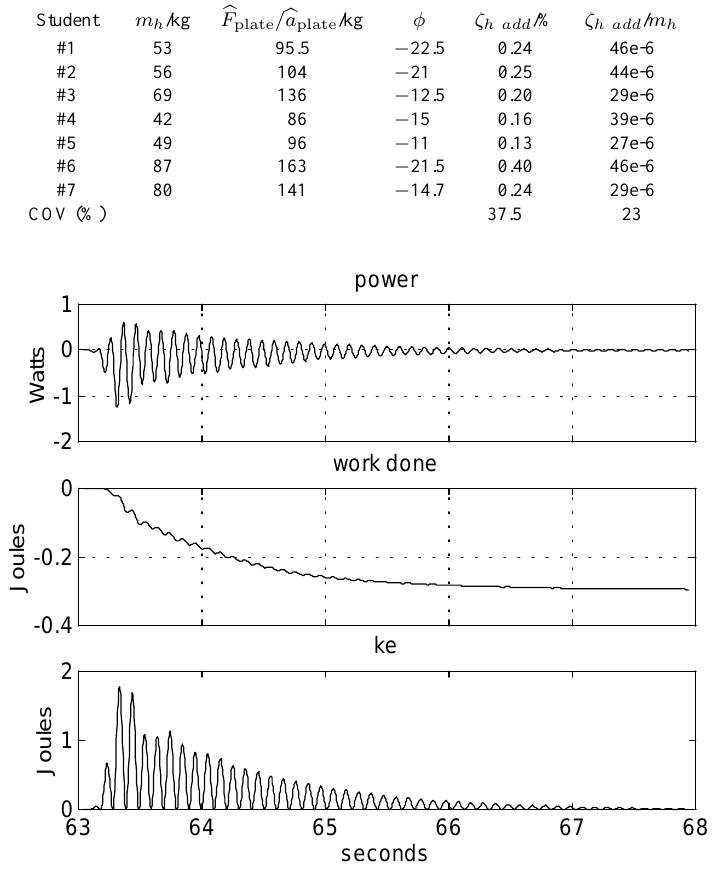
Fig. 9. Top: Energy dissipation rate (power) due to human occupant Lower: Time integral of power, accumulated energy dissipation due to occupant, 0.3 Joules taken out by the occupant Bottom: Total Kinetic energy, maximum 1.8